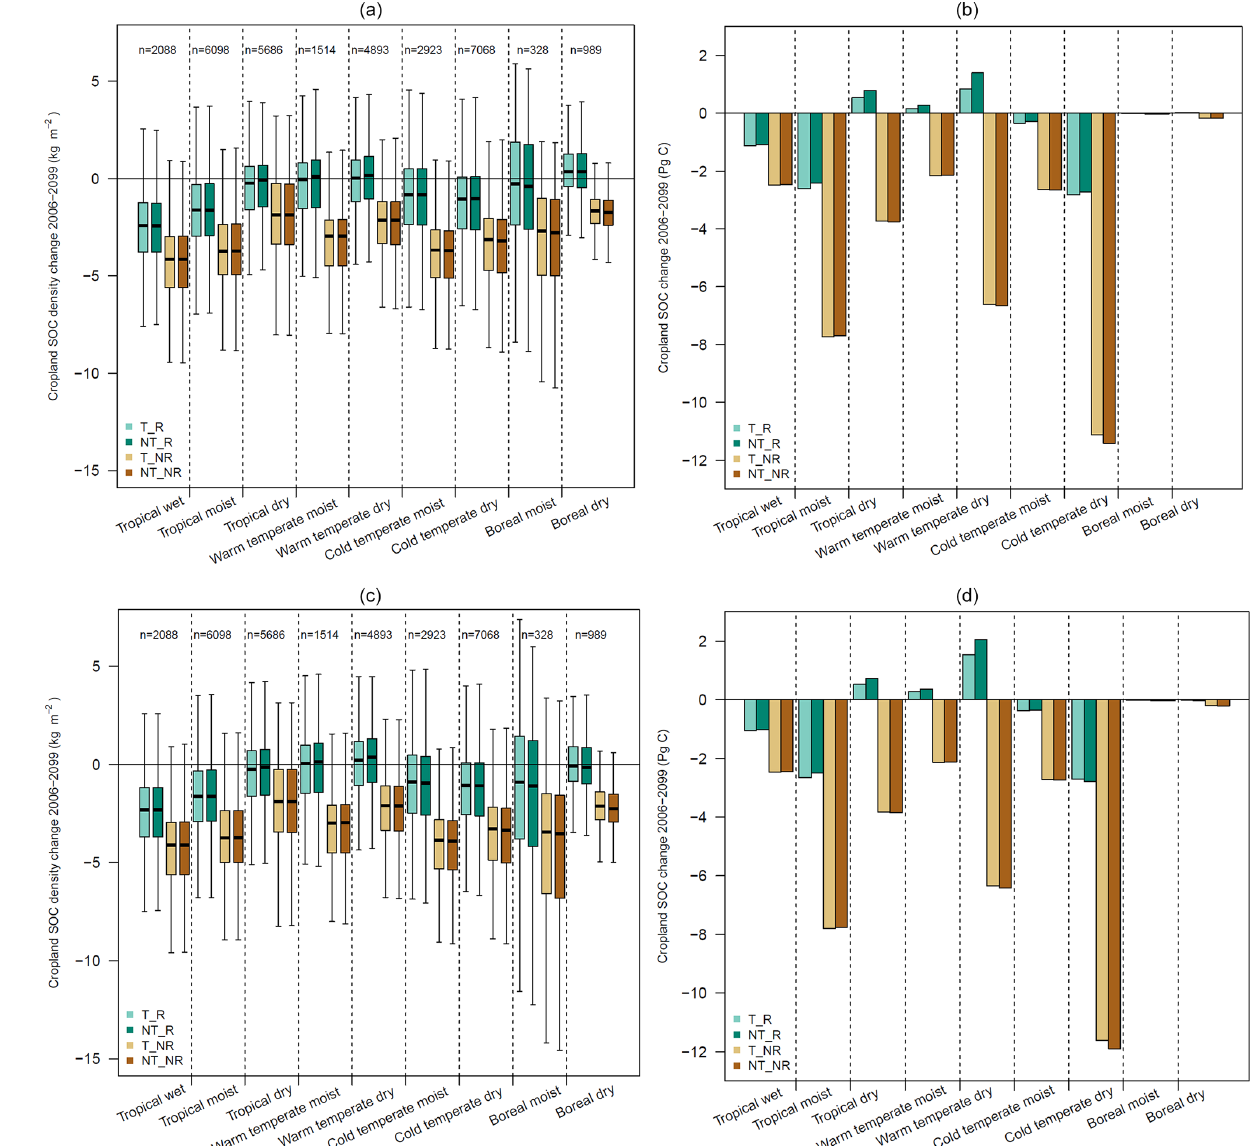
Figure 5. Box plots of cropland SOC density change (kgm − 2 ) and bar plots of total cropland SOC change (Pg C) between the years 2006 and 2099, averaged across the four GCMs (HadGEM2_ES, GFDL-ESM2M, IPSL-CM5A-LR, MIROC5) in RCP2.6 (a, b) and RCP8.5 (c, d) for the climatic regions classified by the IPCC (2006) and the four management systems T_R, NT_R, T_NR, and NT_NR. The same plots for each GCM can be found in Figs. S5 and S6 in the Supplement; n is the number of cropland cells included in each climate region.